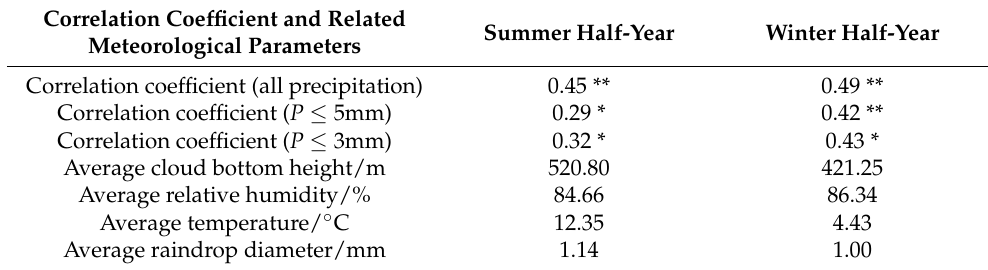
Table 1. Correlation coefficient between precipitation δ 18 O and cloud bottom height and related meteorological